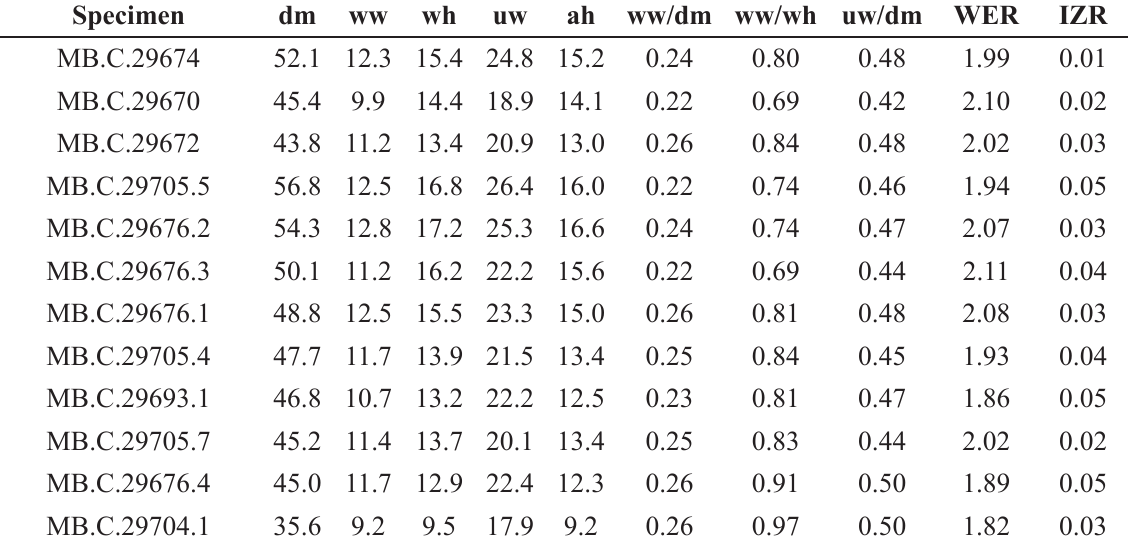
Table 2. Conch dimensions (partly estimated) and ratios of selected specimens of Shevyrevites shevyrevi Teichert & Kummel in Teichert et al. (1973) from Baghuk